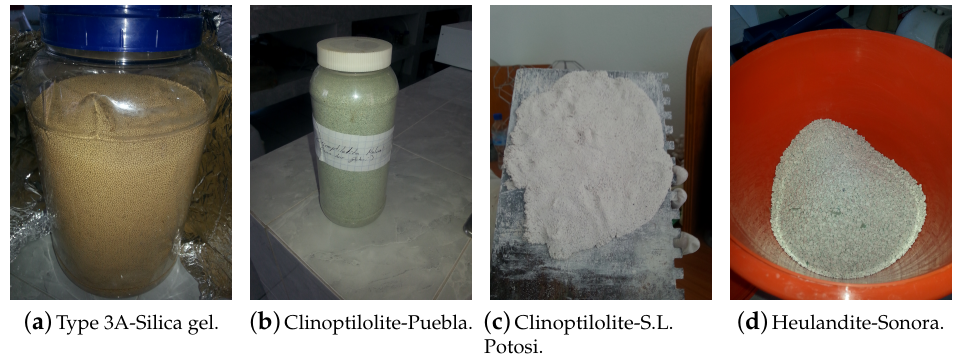
Figure A12. Desiccator with cover to reduce the exchange of temperature with the outside.